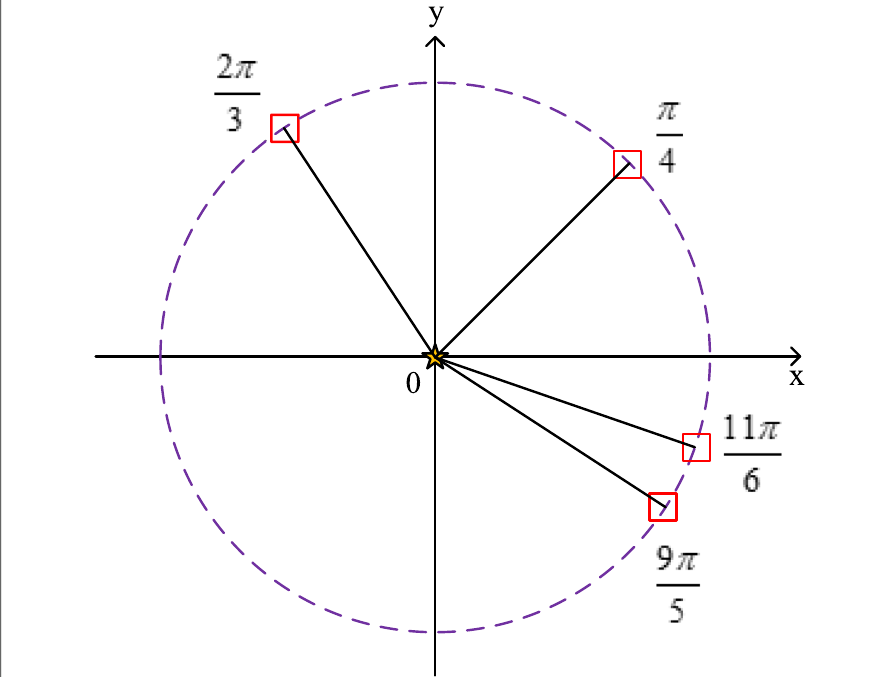
Fig. 4 Single anchor and its 4 hearable agents: the anchor is placed at the origin of p 0 = ( 0,0 ) , and K = 4 hearable agents located on a given